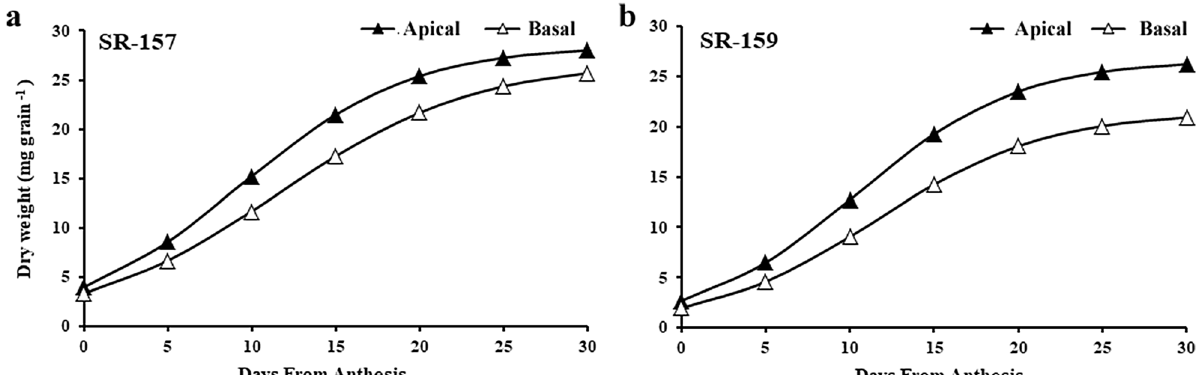
Figure 1. Dry mass accumulation of apical (close symbols) and basal (open symbols) spikelets during post- anthesis period from 0 to 30 days at 5 days interval in SR-157, ( a ) and SR-159, ( b ) The graph has been plotted in terms of logistic growth curve equation, W ( t ) = Wo M / (cid:31) Wo + ( M − Wo ) −